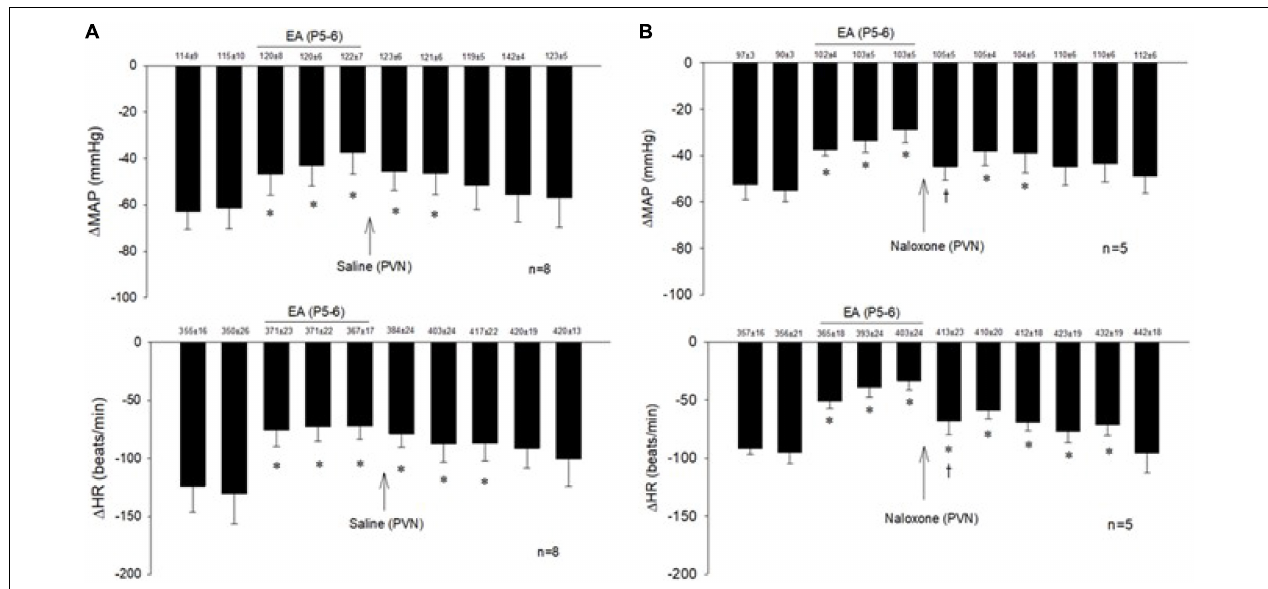
FIGURE 2 | Electroacupuncture (EA) at P5-6 acupoints reduced the Bezold-Jarisch responses evoked by PBG every 10 min. EA reduced the inhibitory cardiovascular responses for at least 60 min (A,B) . Blockade of opioid receptors with naloxone in the PVN reversed the inhibitory effects of EA on cardiopulmonary reflex responses (B) in contrast to saline (A) . Baselines blood pressures and heart rates in mean ± SEM shown above bars were not significantly different throughout experiments. ∗ Significant difference compared with control PBG response. † Significant difference from the preceding PBG response.